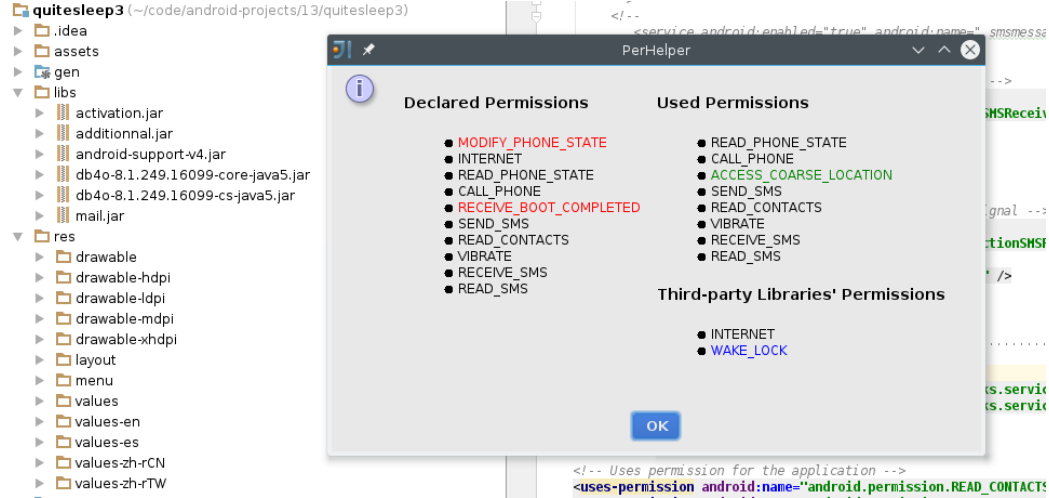
Figure 3. A screenshot showing permission set analysis results for the app “Android